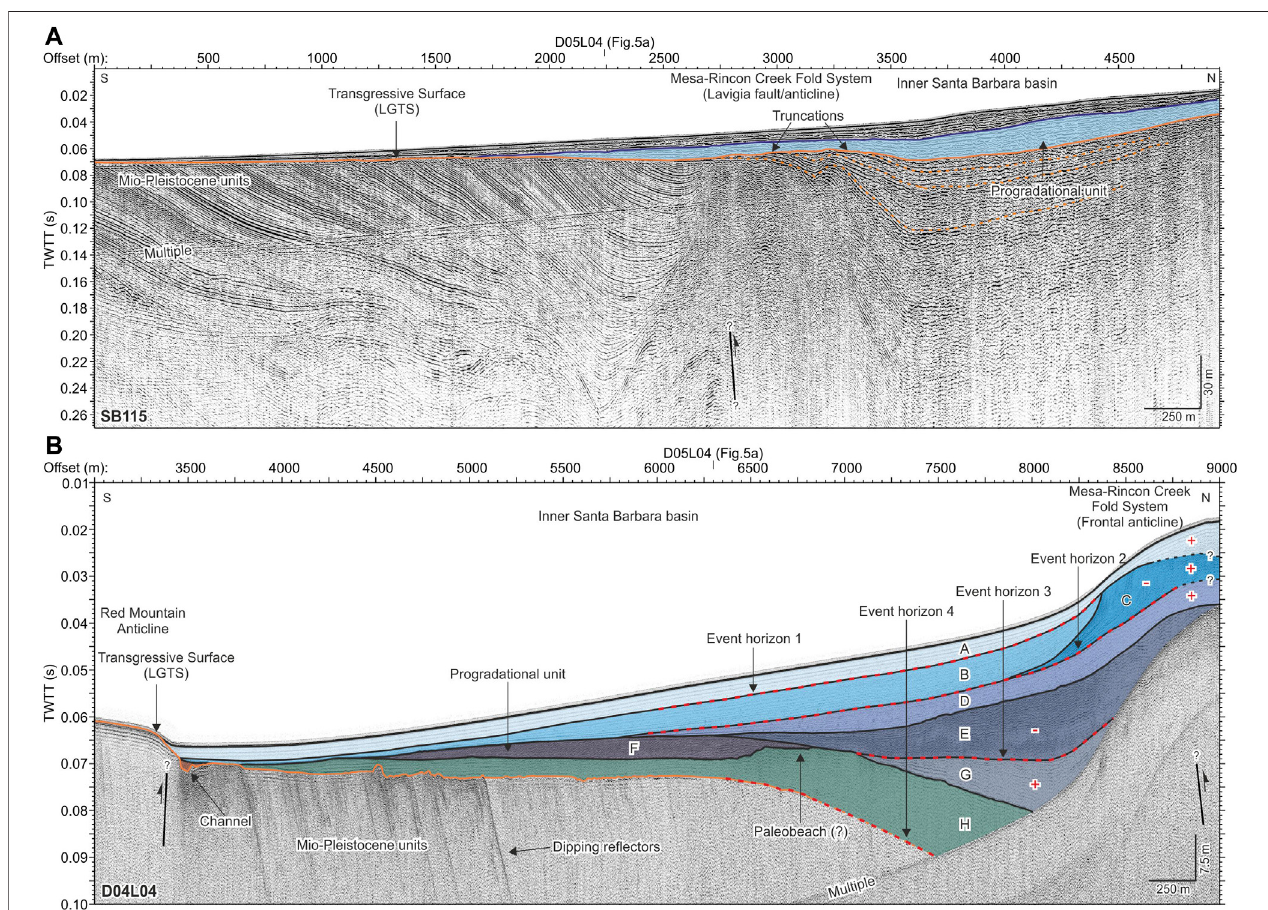
FIGURE 4 | (A) Interpreted USGS mini-sparker dip pro fi le SB115 showing the folded Late Pleistocene units and a truncation surface related to the Last Glacial transgressive surface (LGTS; continuous orange line). To the north of the Mesa-Rincon Creek fold system, the location of the LGTS is not well constrained and different possibilities are shown (orange dashed lines). The light blue unit bounded by a dark blue line corresponds to a progradational unit. (B) Interpreted CHIRP dip pro fi le D04L04 showing the folding of the LGTS (orange continuous and dashed line) related to some of the active faults in the area. Different seismostratigraphic units (A – H) are identi fi ed based on changes in stratal geometry. Positive (+) and negative ( − ) symbols (in red) correspond to the identi fi cation of aggradational and progradational units, respectively. The red dashed lines identify horizons corresponding to different deformation events (i.e., inferred earthquakes). The location of both pro fi les is shown in Figures 2 , 3 . Uninterpreted pro fi les are provided in Supplementary Figure S4 .